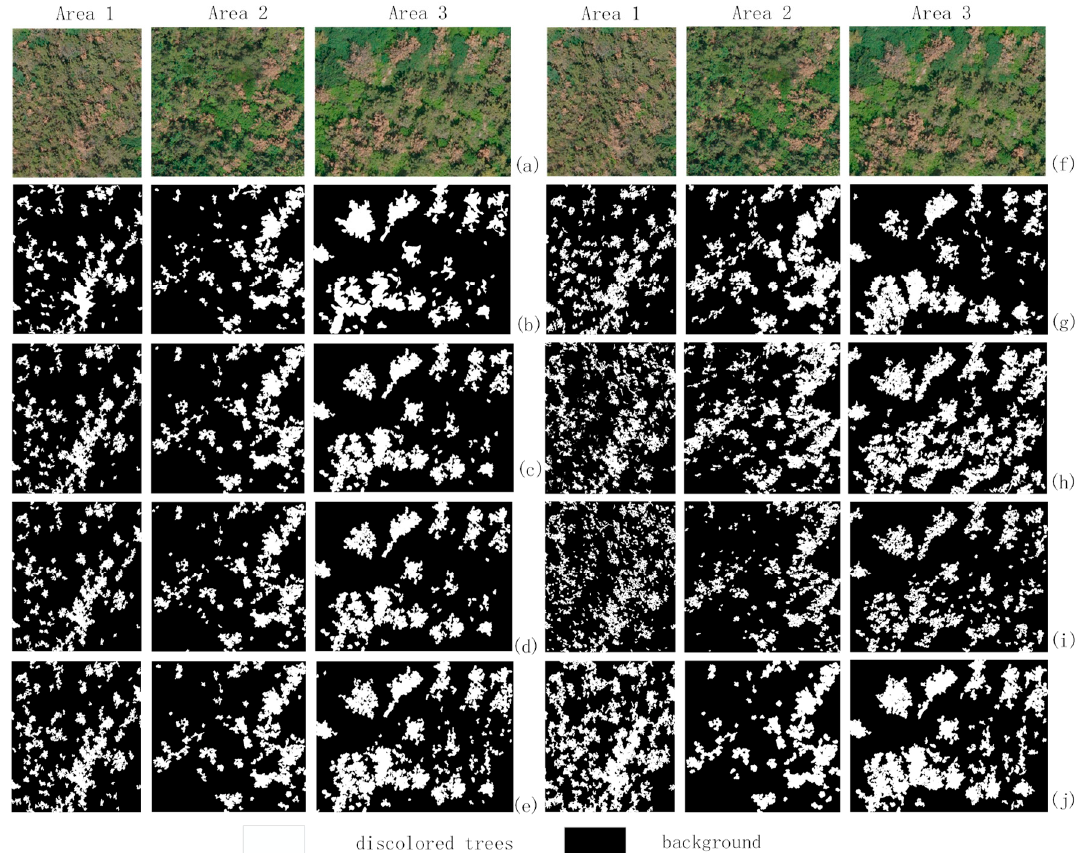
Figure 8. Extraction results by different methods. ( a ) UAV image; ( b ) ground truth; ( c ) our proposed